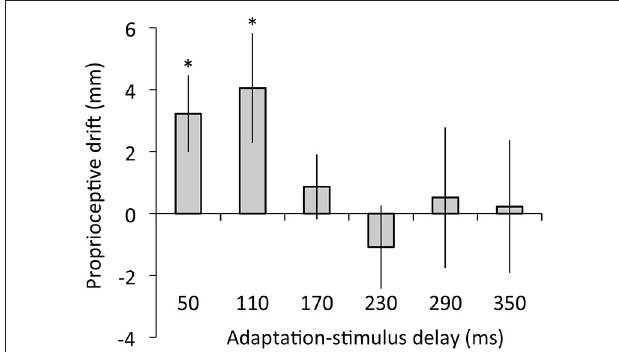
FIGURE 5 | Proprioceptive drift as a function of adaptation-stimulus delay . Error bars denote ± 1 standard error of the mean. Asterisks indicate values that are significantly different from zero (* p <